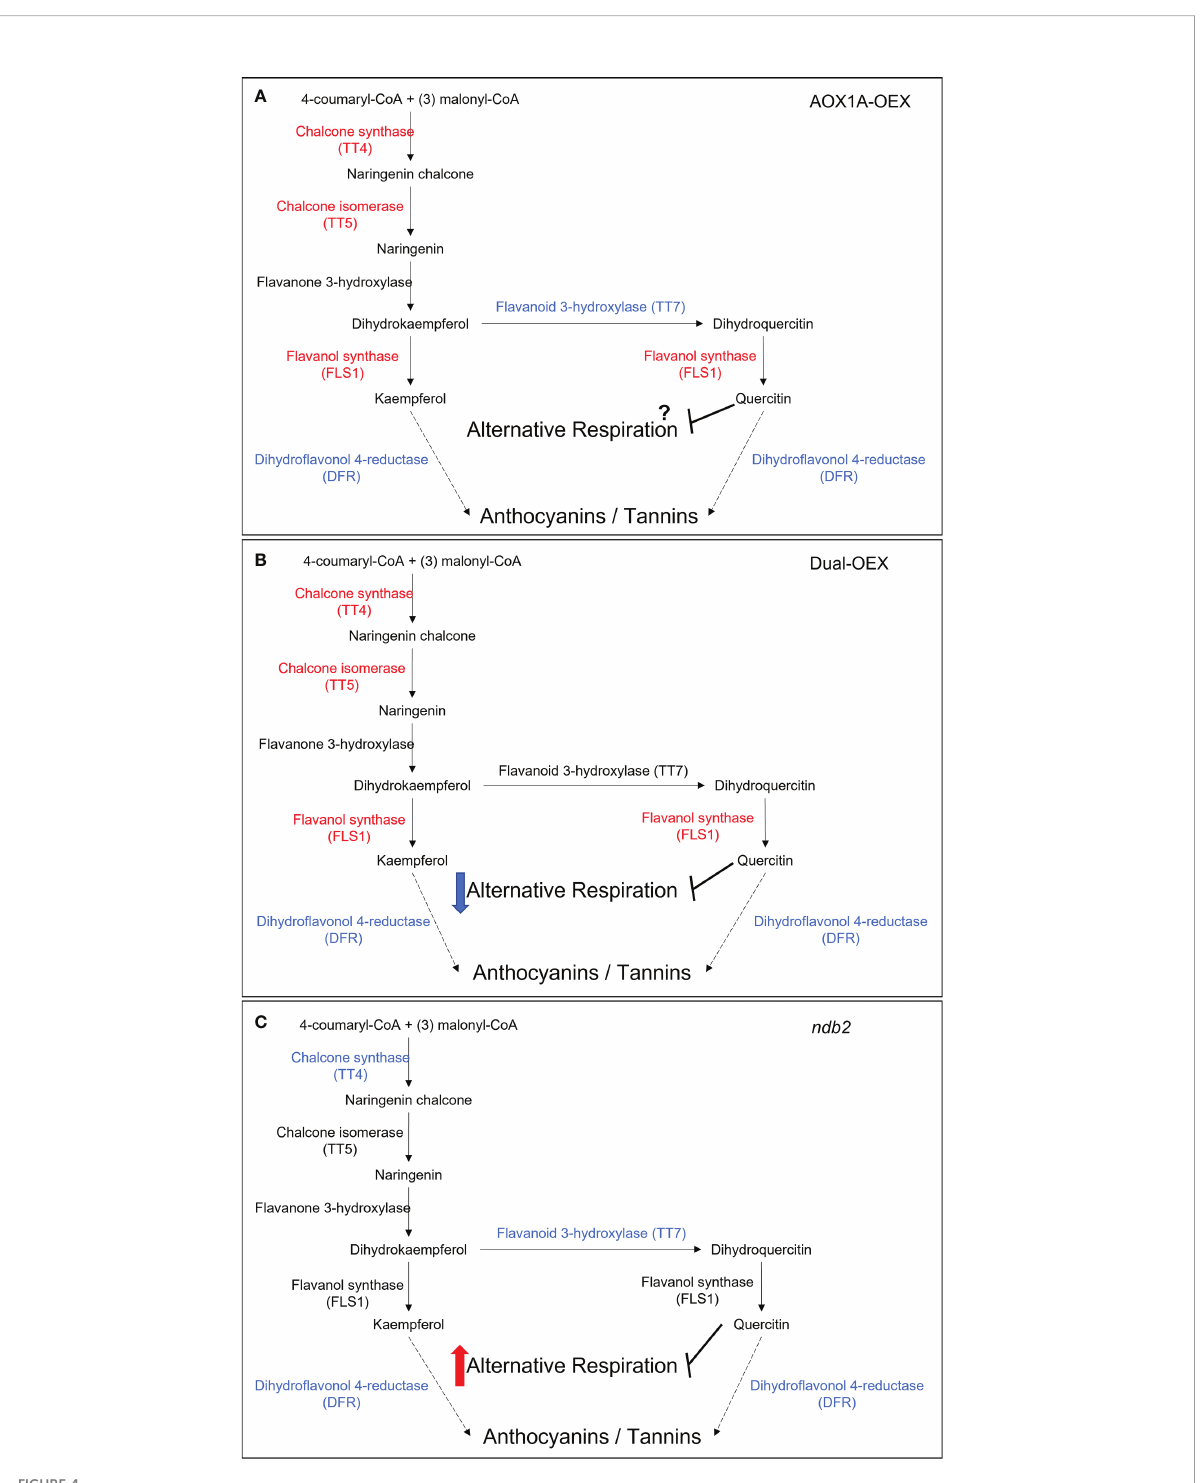
FIGURE 4 Flavonoid biosynthesis pathways and the potential effects on alternative pathway regulation in (A) AOX1A overexpression line, (B) dual overexpression line and (C) NDB2 knockout line. Major metabolite and enzyme steps in black. Red indicates an up-regulated transcript, blue indicates a down-regulated transcript. Red and Blue arrows represent potential down- and up-regulation of AOX activity. Dotted arrow indicates a multiple-step pathway with details